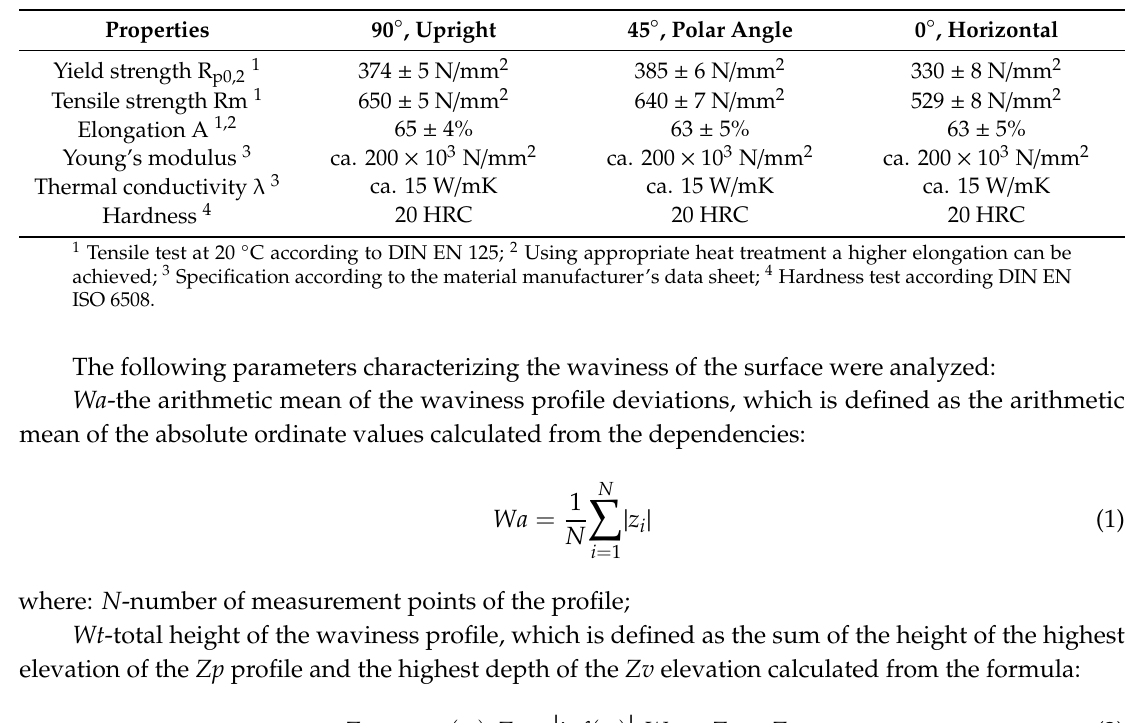
Table 2. Mechanical properties of 316L